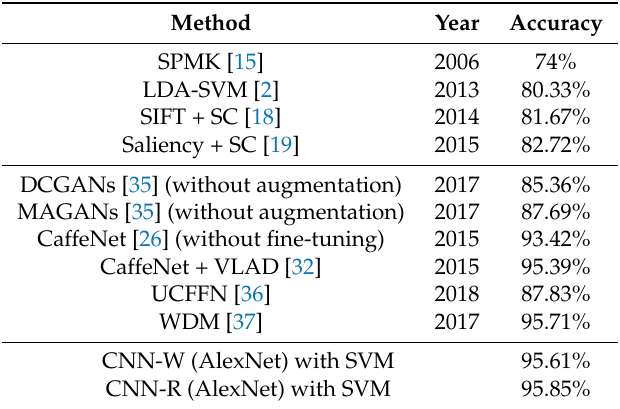
Table 1. Classification accuracy of compared methods on the UC-Merced